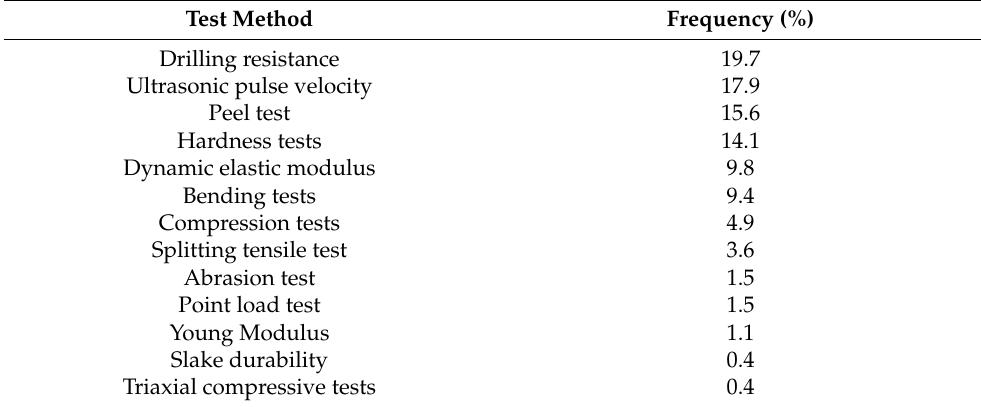
Table 2. Distribution of the test methods used to assess the strengthening in stone consolidation